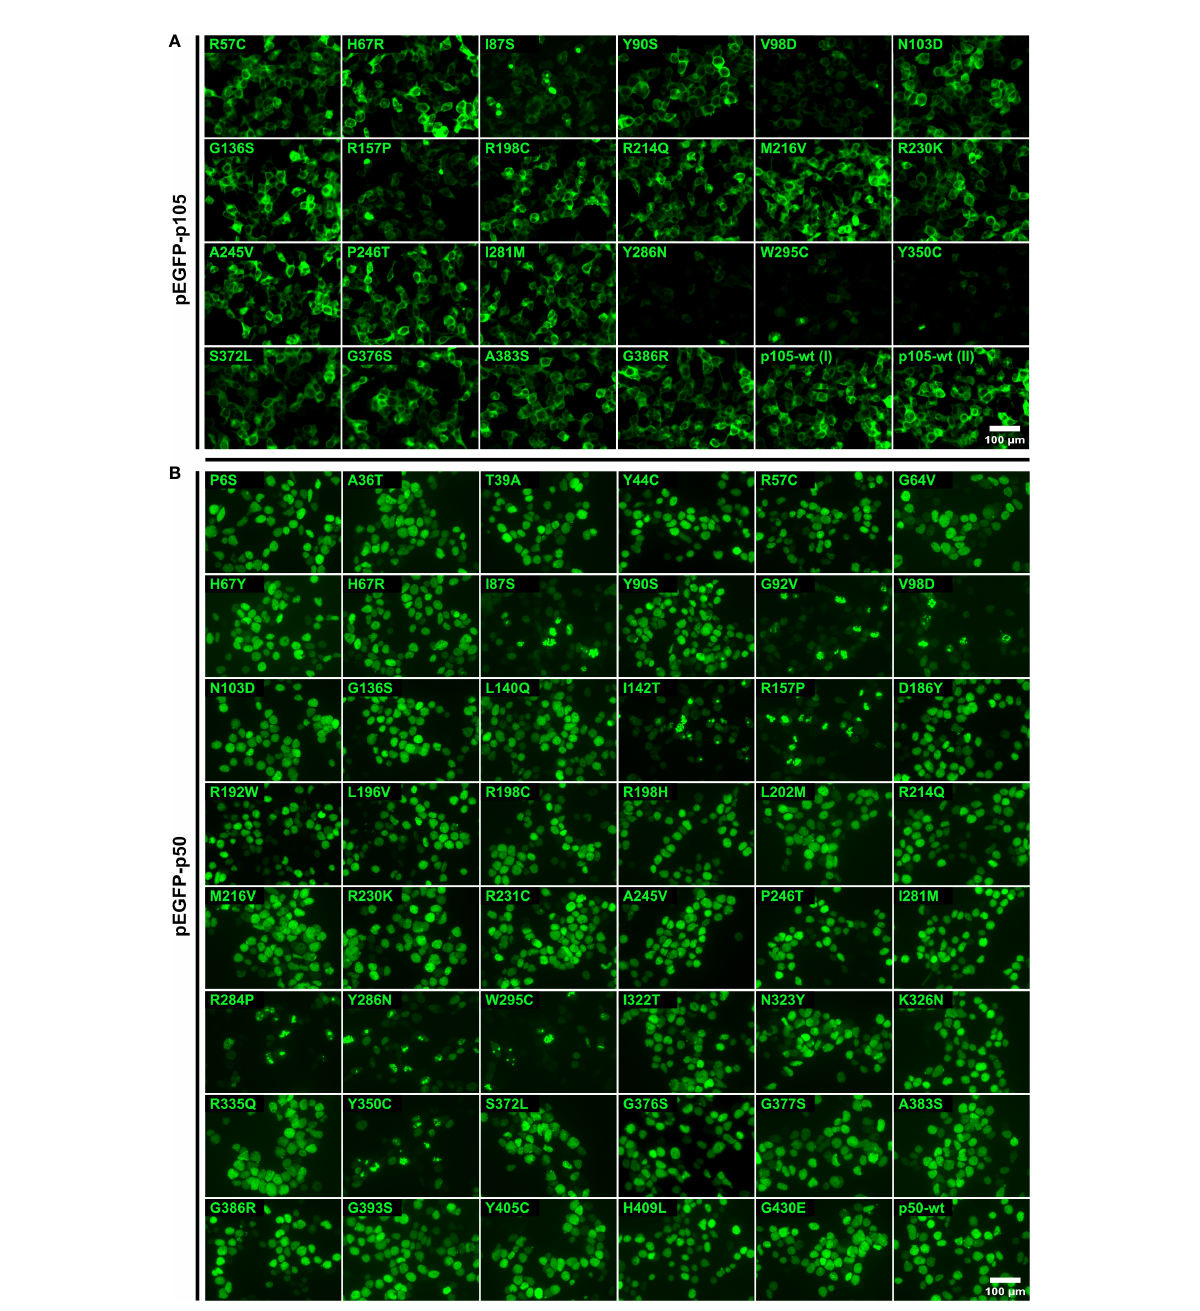
FIGURE 2 Deleterious missense variants causing protein loss are characterized by weak p105 expression and sub-nuclear deposition of p50. HEK293T cells were transiently transfected with expression vectors encoding EGFP-tagged proteins of wildtype or mutant p105 or p50 as indicated and analyzed by fl uorescence microscopy. The known devastating Y350C variant was included as a control. Scale bars are indicated. Overlay images with stained nuclei are shown in Supplementary Figures 1A, B. Representative results are shown. (A) Ectopically expressed p105 predominantly localizes to the cytoplasm. EGFP-fused wildtype p105 and non-decaying variants yield robust expression levels. Limited expression and/or aberrant localization indicate severe protein defects (I87S, V98D, R157P, Y286N, W295C, and Y350C). (B) Transiently overexpressed EGFP- tagged wildtype p50 and non-decaying variants show a homogeneous nuclear distribution. Deleterious protein defects are indicated by unusual sub-nuclear protein deposition into aggregate-like structures with high fl uorescence intensities (I87S, G92V, V98D, I142T, R157P, R284P, Y286N, W295C and